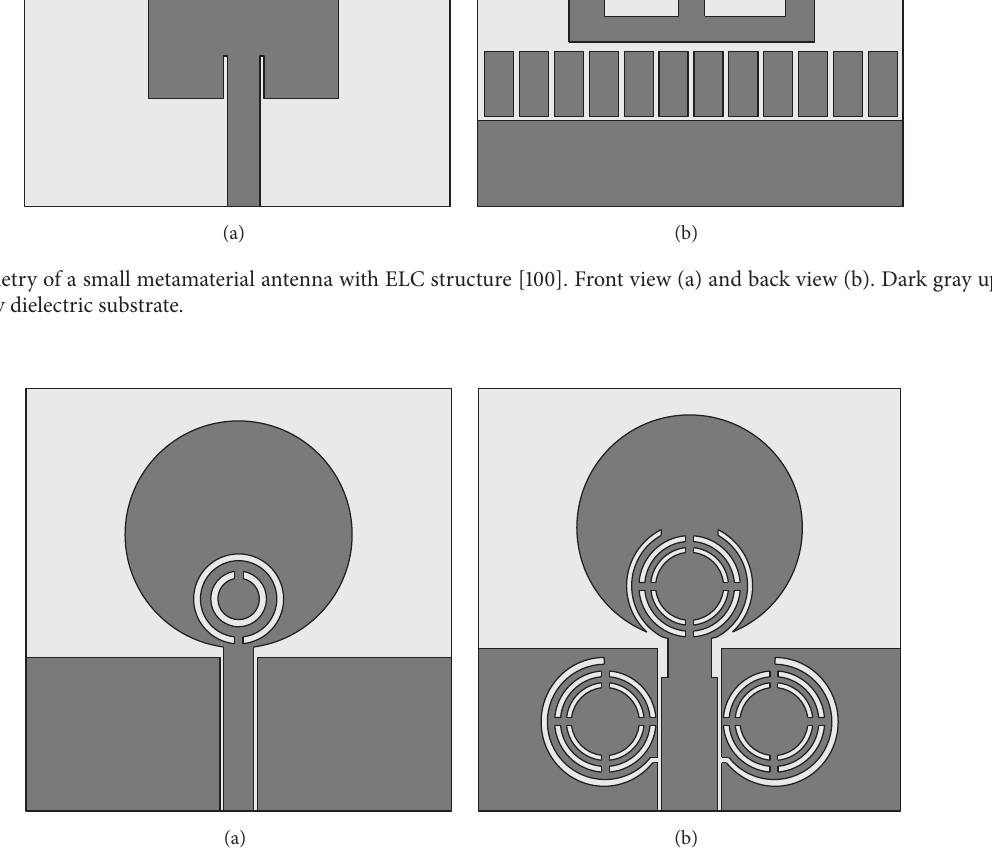
Figure 39: A UWB antenna employing metamaterials to realize a notched band useful to reduce interference with WLAN communication systems [101]. (a) CSRR integrated in the monopole; (b) CSRRs near the CPW. The CSRRs are located near the regions where the magnetic field exhibits its higher values. Dark gray upper metal face and light gray dielectric